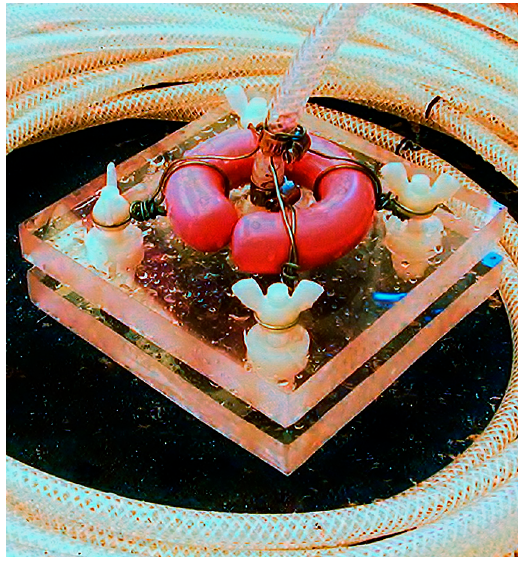
Figure 4. Water sampler fitted with additional ballast. The mass of the lead donut weight adds ballast to the sampler to ensure proper vertical orientation when lowered into the water column.